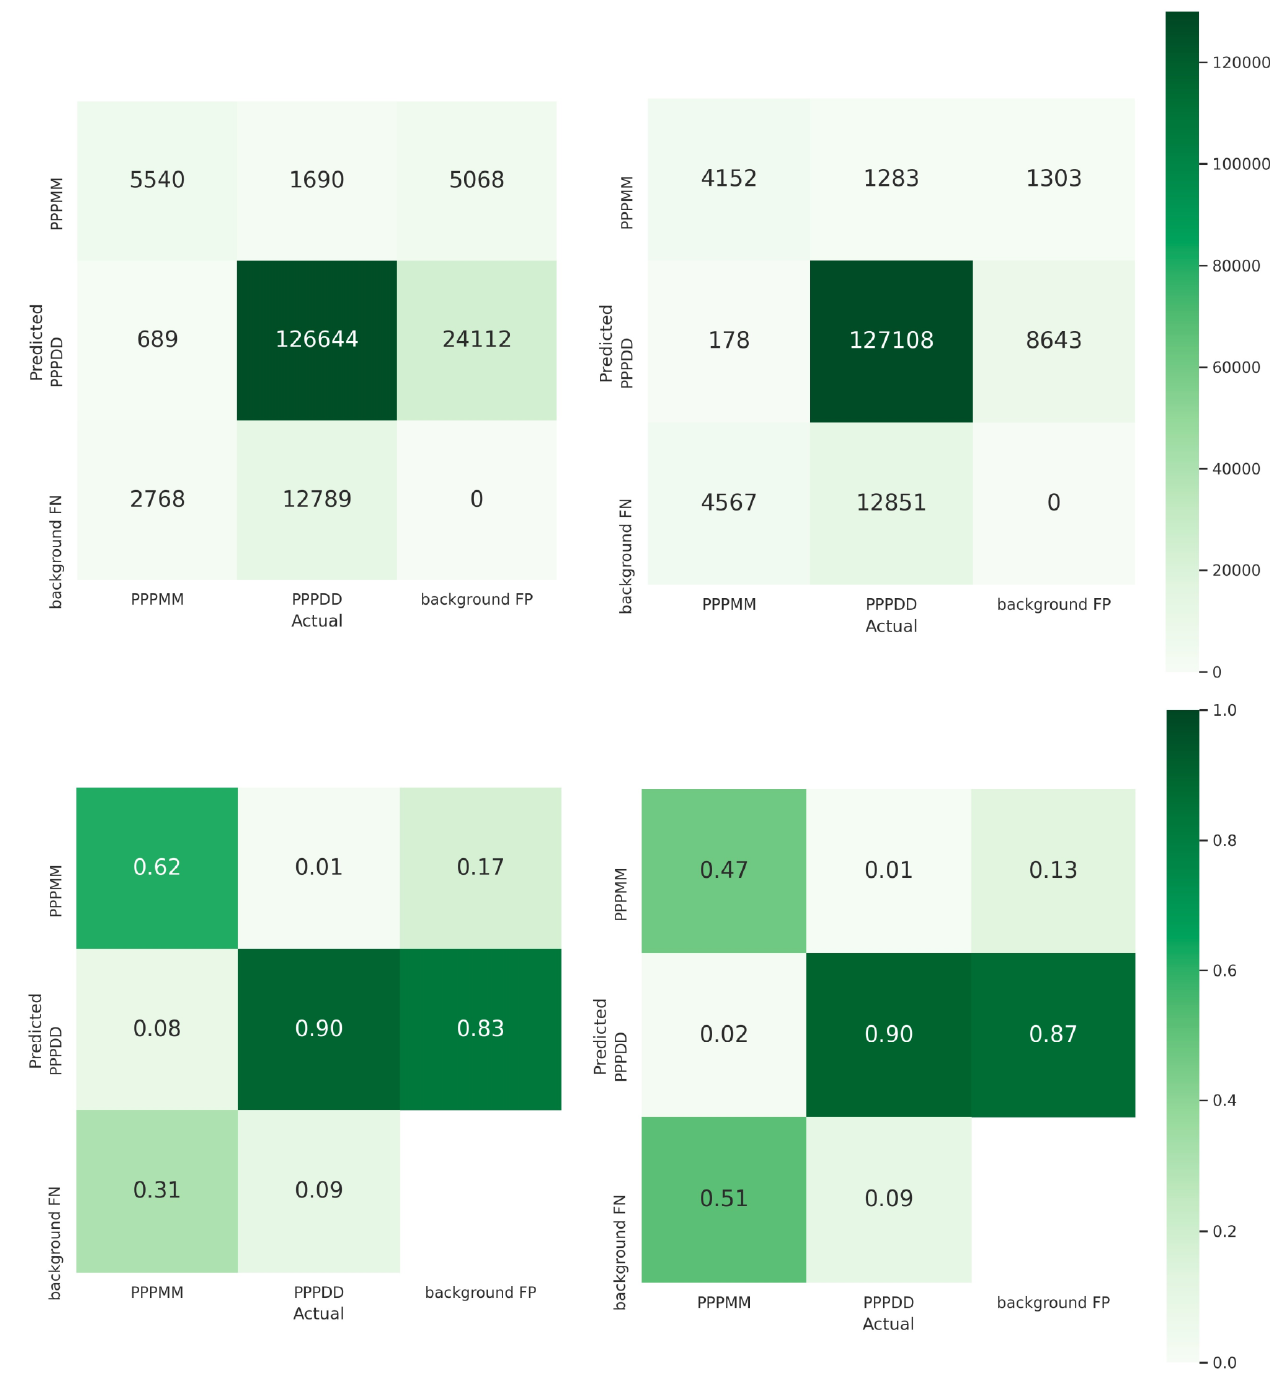
Figure 9. The normalized and non-normalized confusion matrices obtained from EfficientDet ( Left pictures) and YOLOv5 ( Right pictures) on the generated synthetic images.